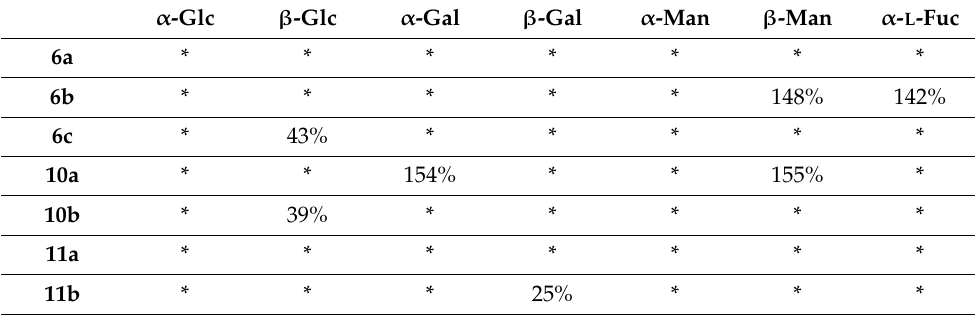
Table 1. Residual activity of enzymes at 5 mM of the active final compounds. α